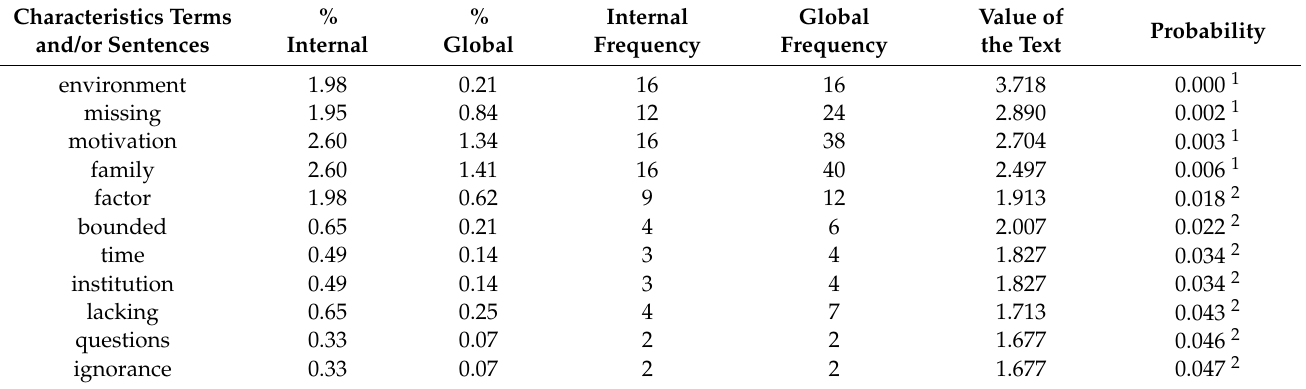
Table 1. Teachers’ answers to the question: “What is, in your opinion, the cause of school